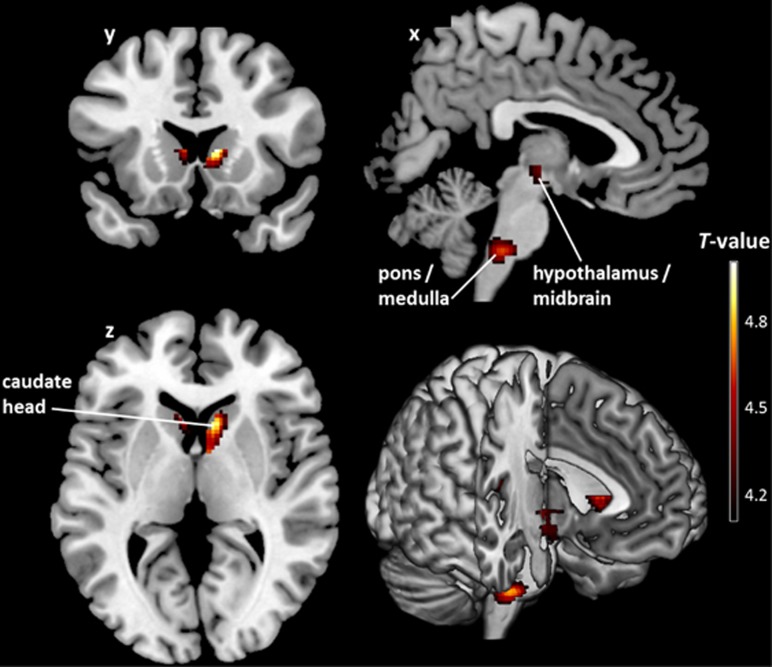
Brain regions where cannabinoid 1 receptor (CB1R) availability covaries negatively with log body mass index (BMI) in healthy controls. T map of significant negative correlations between CB1R availability and log BMI in predefined homeostatic and reward-related regions of interest shown at a threshold of PFWE-corrected<0.05 (both at the voxel- and cluster-level; n=26). The colored voxel-based statistical parametric mapping (SPM) results of the negative correlations in sagittal (x), coronal (y) and transverse (z) sections are overlaid on a normalized canonical image (ch2better-template) available in MRICron software. The color bar expresses T-score levels.